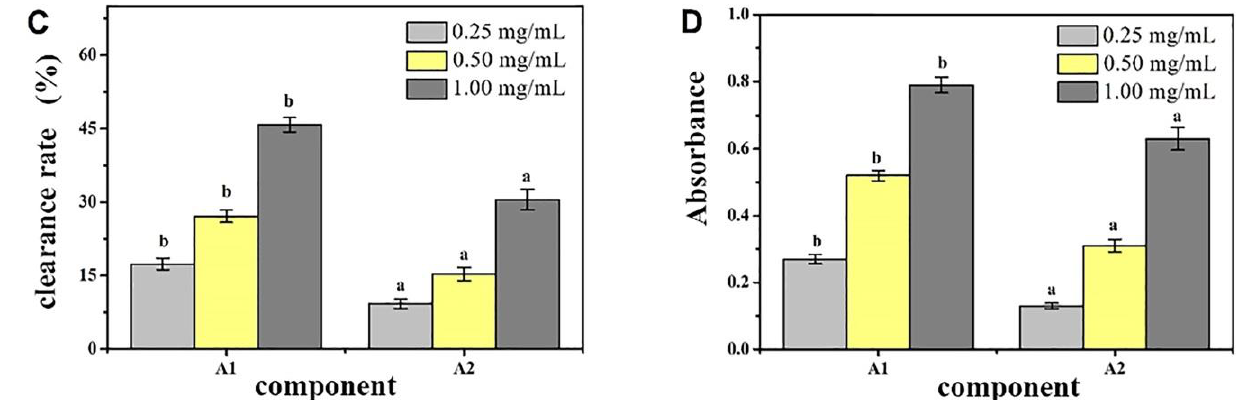
Figure 2. Antioxidant activity of different peptides fractions A1 and A2 from Camella vietnamensis in vitro. (Note: ( A ) was the scavenging effect on DPPH, ( B ) was the scavenging effect on ·OH, ( C ) was the total reducing power, and ( D ) was the scavenging effect on superoxide anion.)